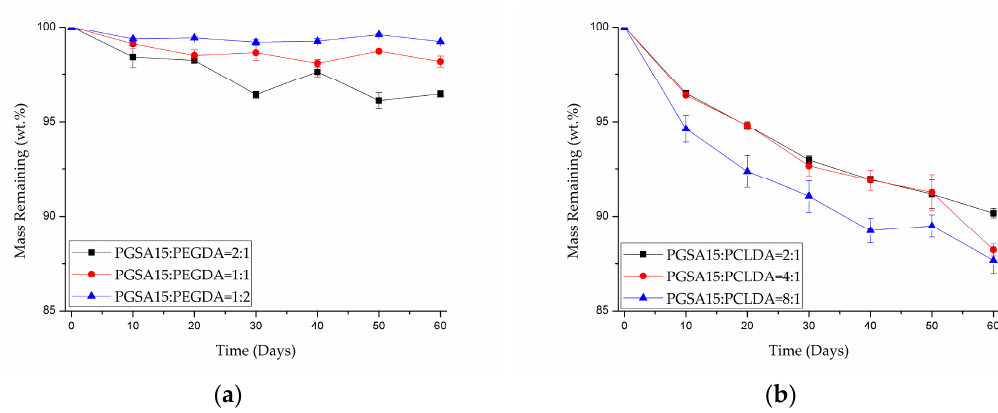
Figure 6. Mass remaining of ( a ) PGSA15- co -PEGDA and ( b ) PGSA15- co -PCLDA in various ratio degraded by 20 U/mL of lipase solution over 60 days at 37 °C. Table 5. Mechanical properties of UV-cured PGSA15- co -PEGDA- co -PCLDA in various weight ratio ( n ≥